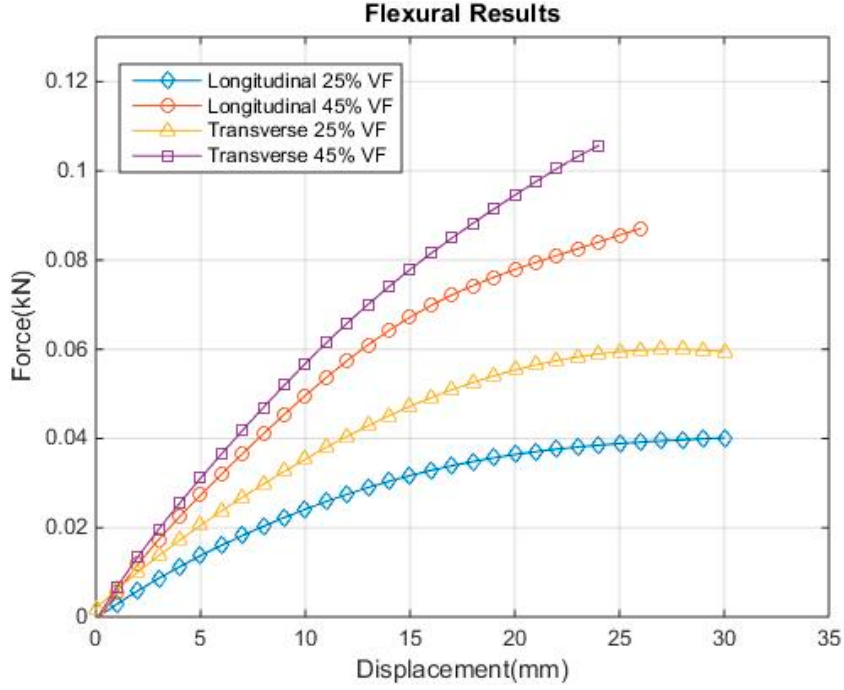
Figure 6. Three-point bending force displacement curves for the longitudinal and transverse directions.